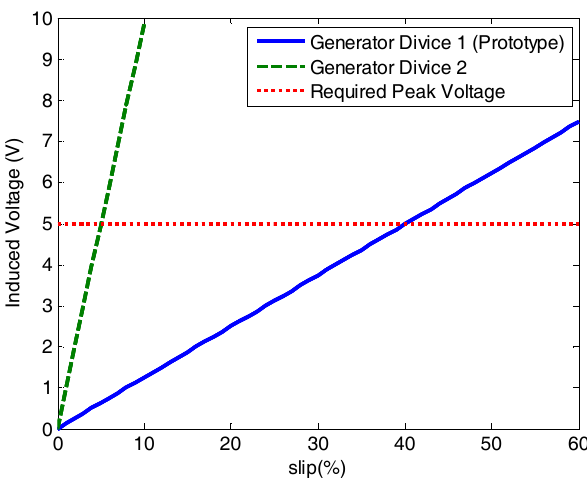
Figure 16. Estimation for the induced voltage in two generating devices with different dimensions.